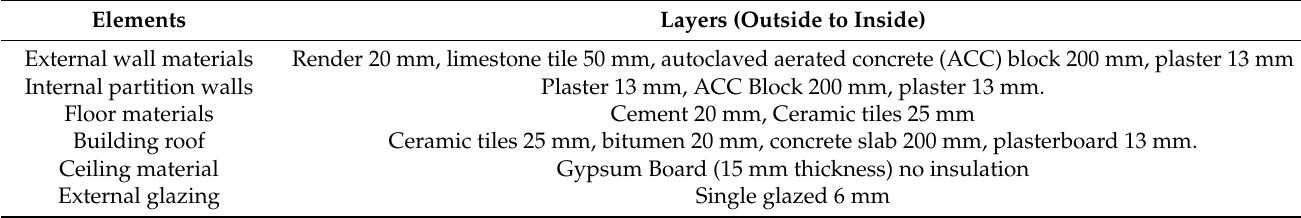
Table 1. List of the classroom materials and modelling settings—(source: Department of Maintenance, Ministry of Education, field